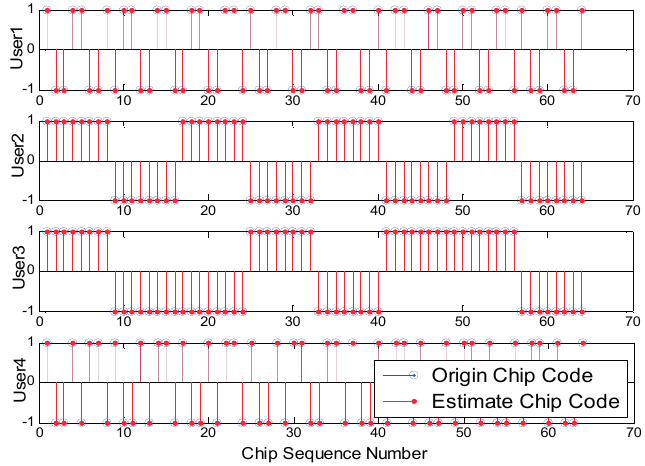
Figure 4. BER performance comparison among the proposed blind separation scheme and conventional scheme.